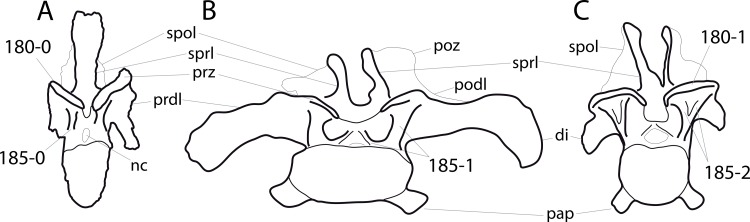
Cervical vertebra 11 of eusauropods.Cervical vertebra 11 of Jobaria tiguidensis MNN TIG (A; traced from photo by J Carballido), Camarasaurus supremus AMNH 5671 (B; based on Osborn & Mook, 1921), and Diplodocus carnegii CM 84 (C; based on Hatcher, 1901) in anterior view. Note the straight (A; C180-0), in contrast to convex prezygapophyseal facet (C; C180-1), and the different morphologies of the centroprezygapophyseal lamina (single, A, C185-0; divided, and connecting to tprl, B, C185-1; divided with both branches connecting to prezygapophysis, C, C185-2). Abb.: di, diapophysis; nc, neural canal; pap, parapophysis; podl, postzygodiapophyseal lamina; poz, postzygapophysis; prdl, prezygodiapophyseal lamina; prz, prezygapophysis; spol, spinopostzygapophyseal lamina; sprl, spinoprezygapophyseal lamina. Scaled to the same condyle height.